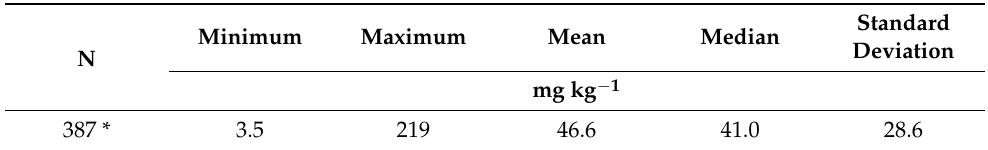
Table 1. Statistical parameters characterizing variability of total Pb concentration in the soils of SMNP (data source